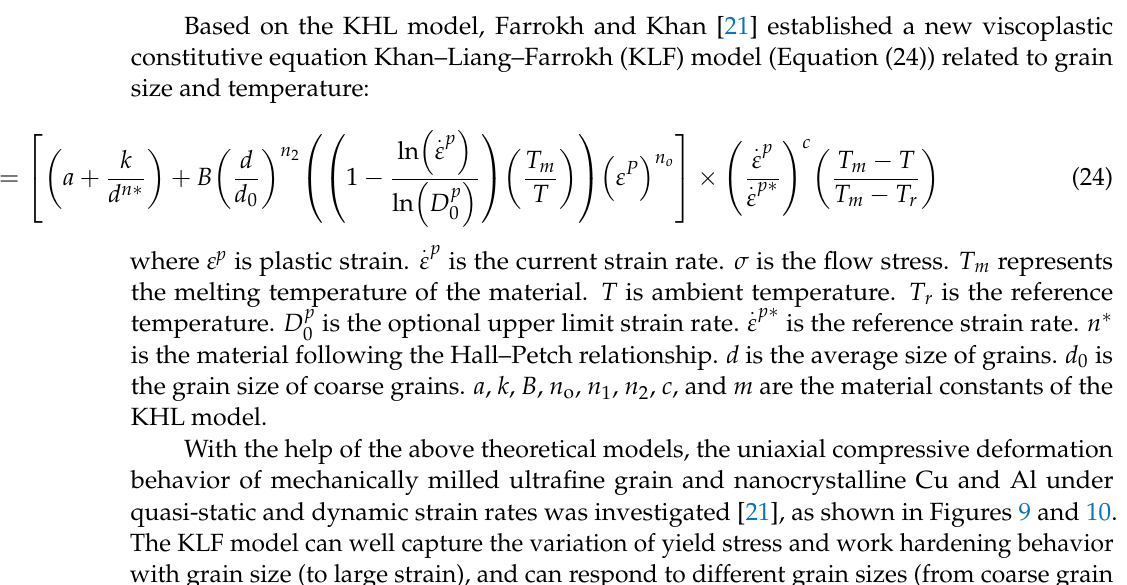
Figure 8. Prediction results of mechanical properties of nanocrystalline aluminum based on the KHL model [20].